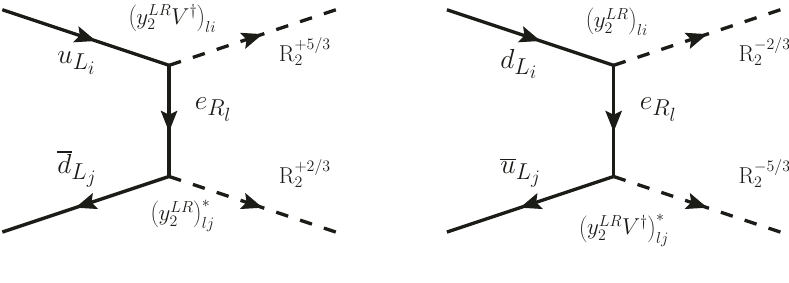
Figure 7 . Asymmetric pair production for the case of R 2